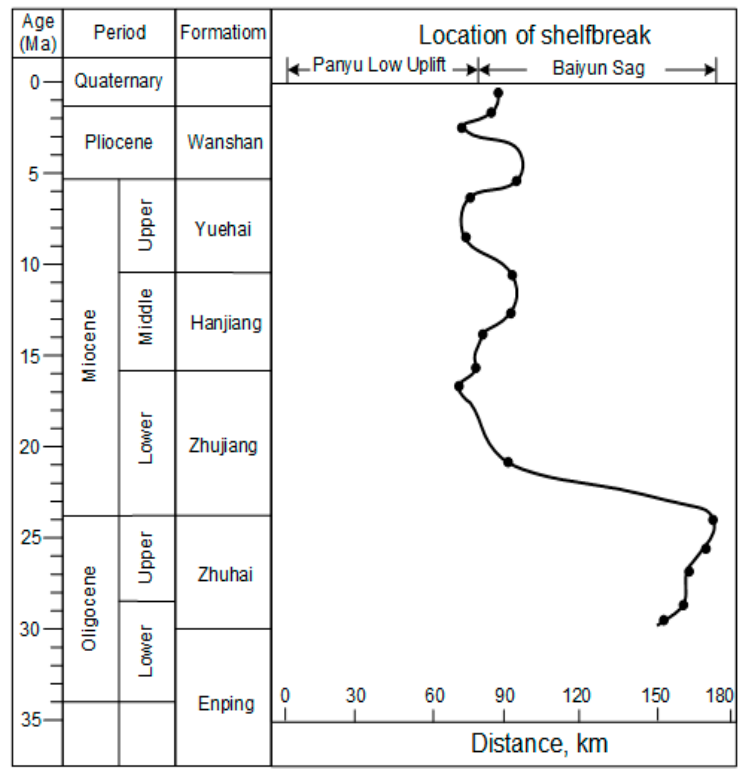
Figure 3. Schematic diagram showing the sequence-stratigraphic framework of the Baiyun Sag and the migration of shelf breaks from 30 Ma to the present in the PRMB. The location of the shelf break was acquired from Han et al. (2016) [22].